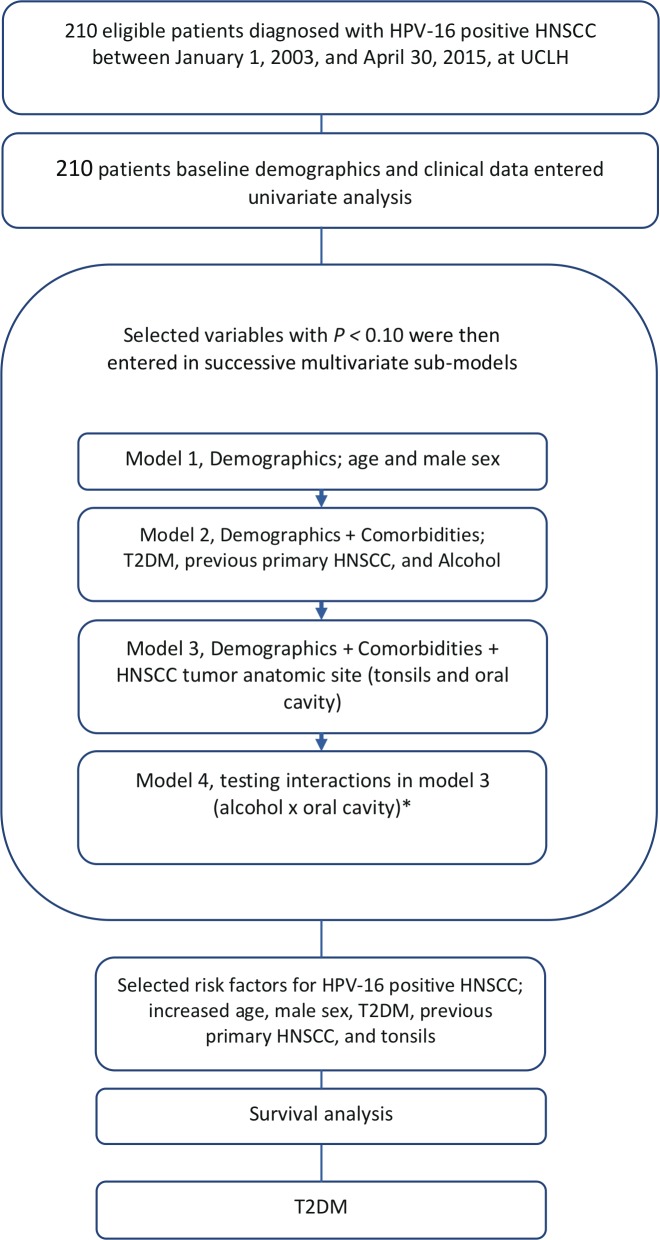
The flow chart of study methodology.Abbreviations: HNSCC, head and neck squamous cell carcinoma; HPV, human papillomavirus, T2DM; type 2 diabetes mellitus, UCLH, University College of London Hospital. *A significant interaction (P < .05) was identified between the oral cavity tumor site and alcohol use; therefore, to remove their simultaneous influence both were added to the final model.